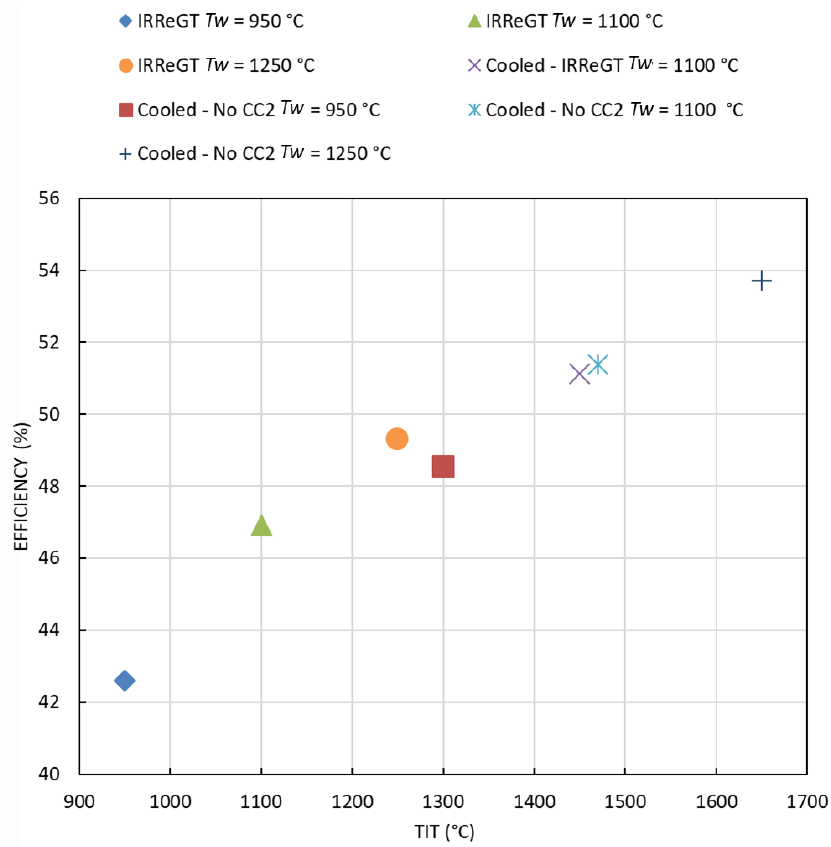
Figure 18. Variation of the GT cycle efficiency with different scenarios.